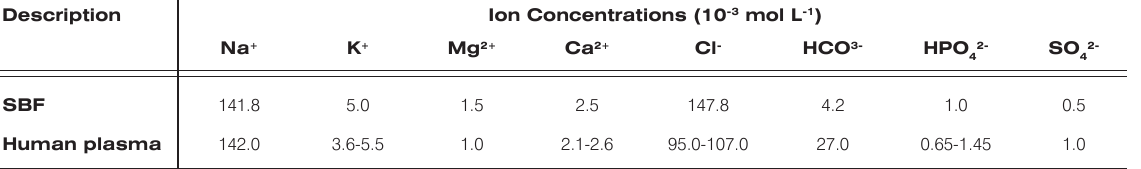
Table 2. Ion concentrations of SBF in comparison with those in human blood plasma [24].